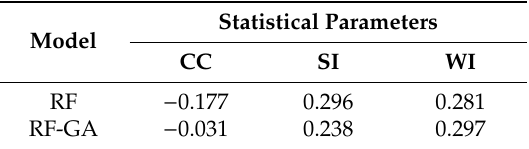
Table 9. Performance evaluation criteria for the RF and RF-GA